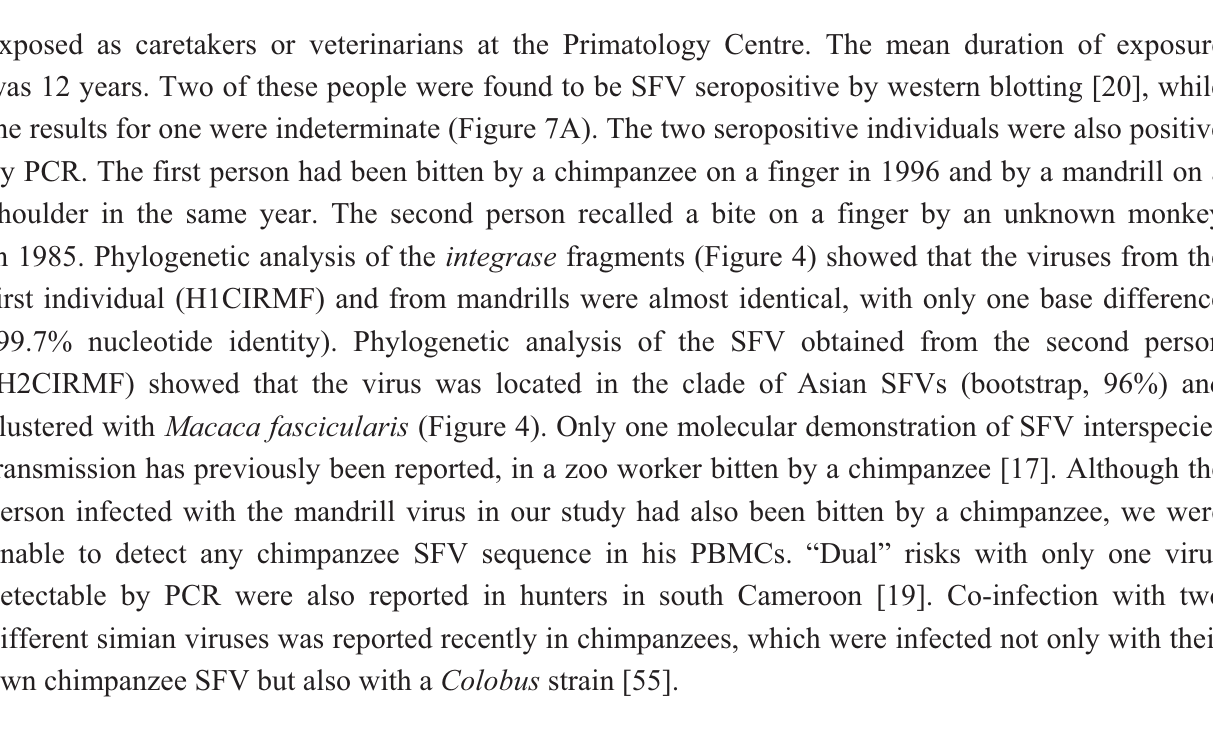
Figure 8. SFV-infected individuals with scars and lesions (red arrow) caused by bites from wild non-human primates during